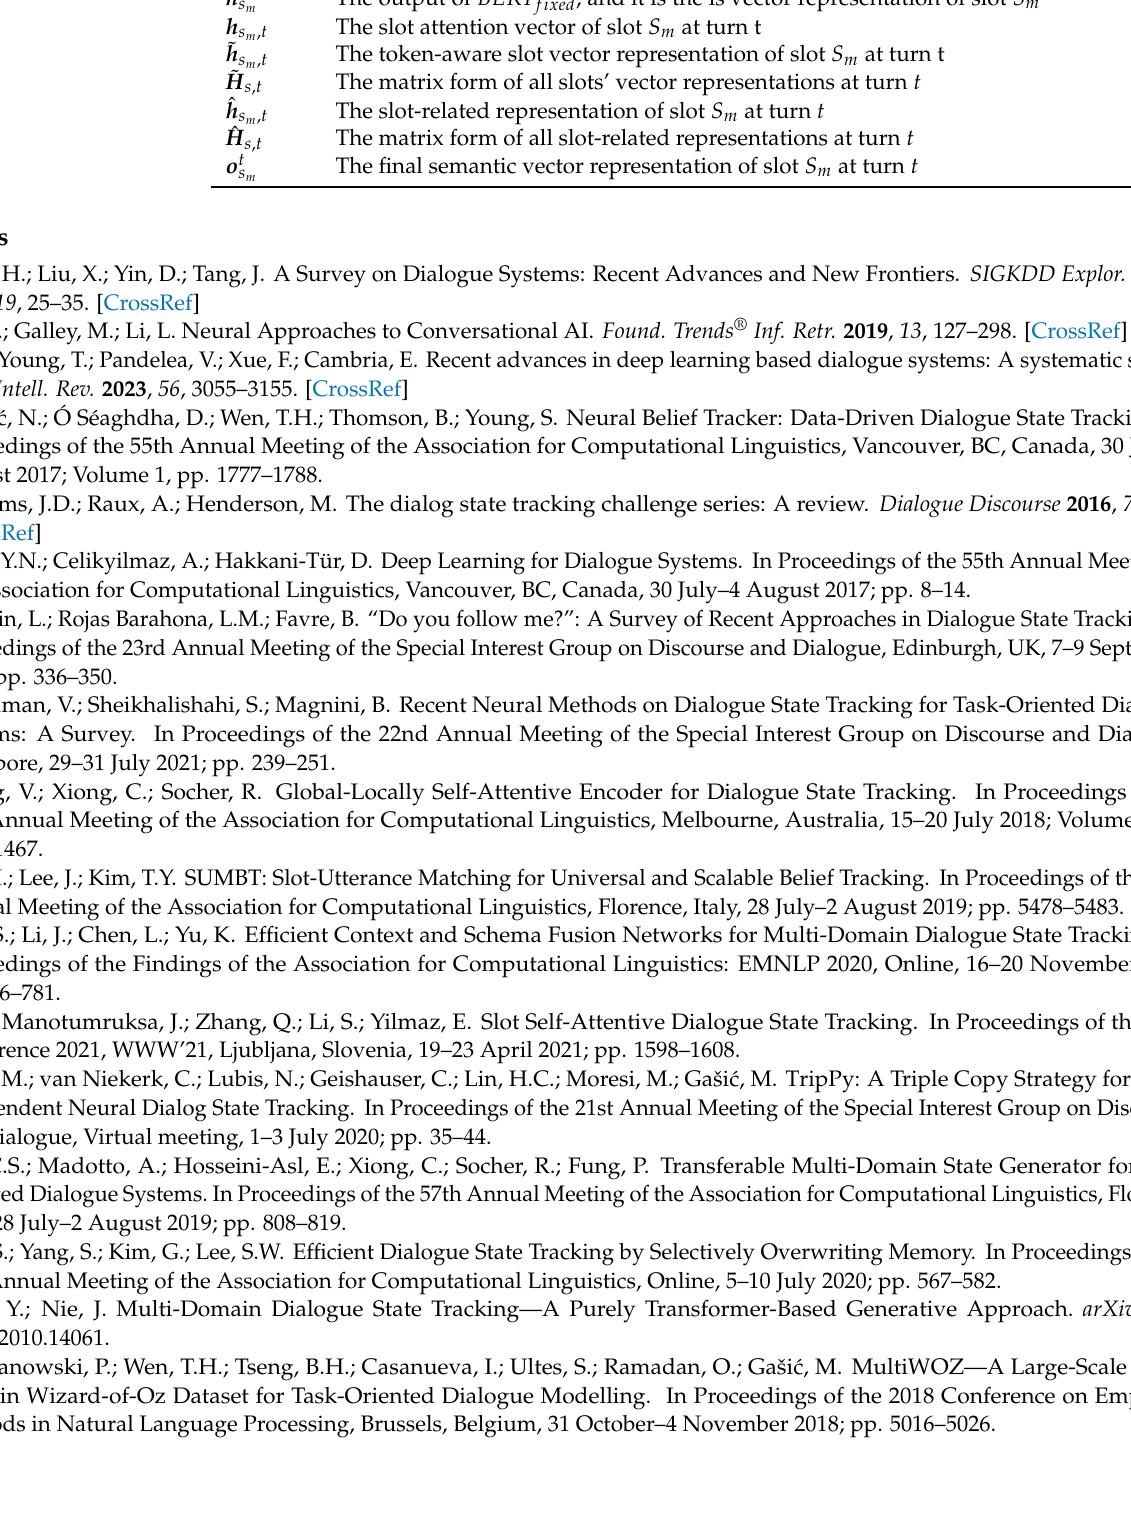
Table A1. Cont. Symbol Description S A set of M predefined slots The m -th slot in S The corresponding value of slot S m at turn